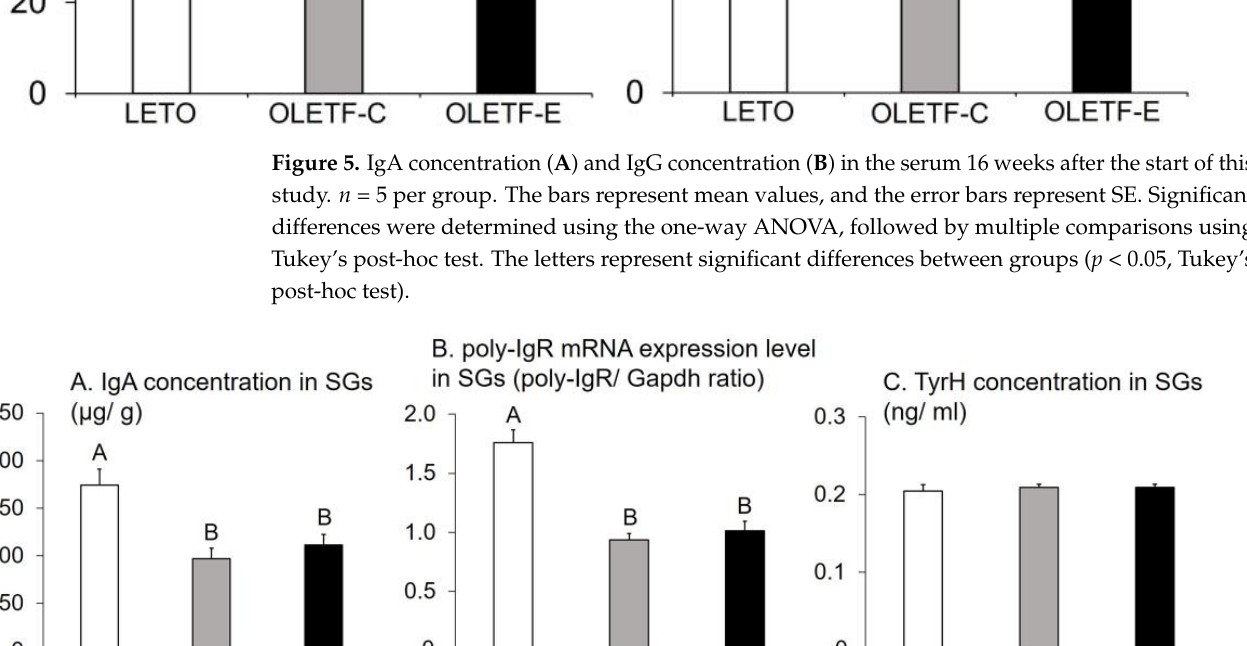
Figure 5. IgA concentration ( A ) and IgG concentration ( B ) in the serum 16 weeks after the start of this study. n = 5 per group. The bars represent mean values, and the error bars represent SE. Signif- icant differences were determined using the one-way ANOVA, followed by multiple comparisons using Tukey’s post -hoc test. The letters represent significant differences between groups ( p < 0.05, Tukey’s post -hoc test).